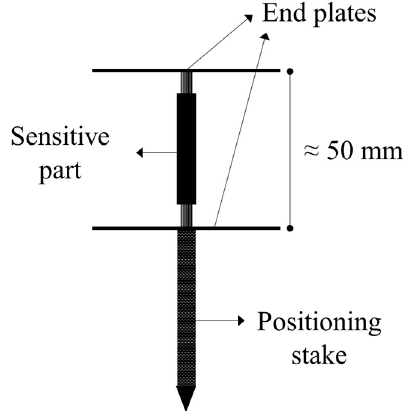
Figure 3. Schematics of a vertical asphalt strain gauge.